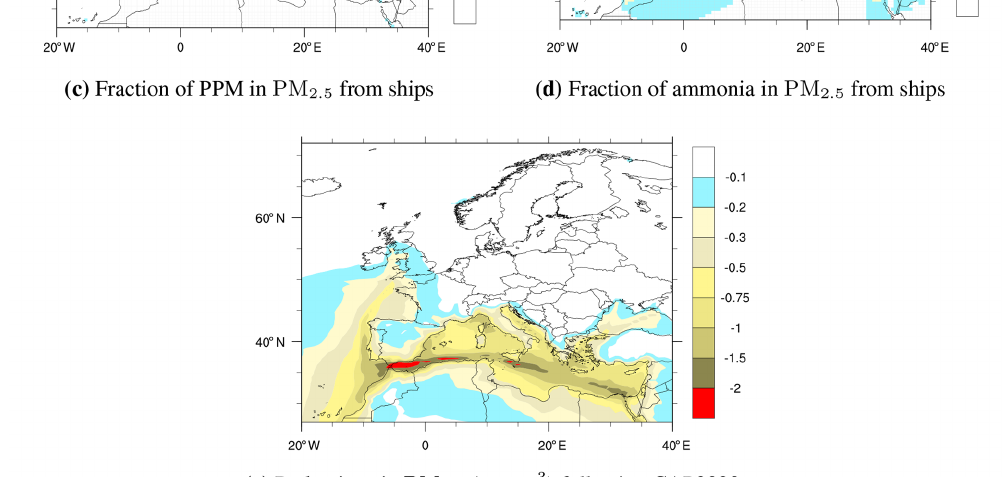
from EMEP MSC-W global